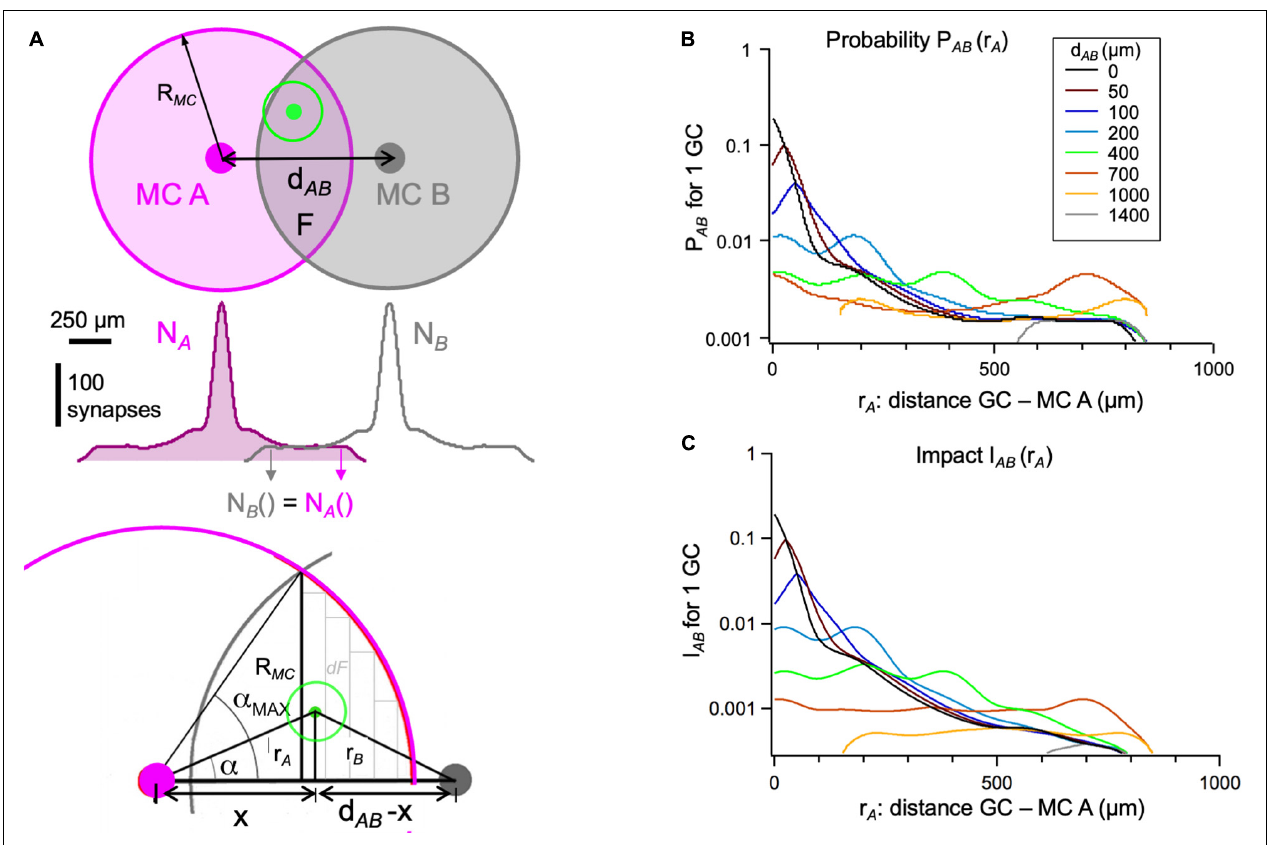
FIGURE 4 | Anatomical connectivity between pairs of mitral cells via one granule cell. (A) Top: Top view of the dendritic fields of MC A (magenta), a second MC B (gray) at distance d AB , and a GC (green) within the overlap area F of the MCs’ dendritic fields. Middle: Illustration of symmetry in N A (r) and N B (r). Bottom: Geometrical parameters relevant for the calculus in Eqs 9, 10 (see also Table 2 ). r A , r B : distance of GC from MC A resp. B. α : angle between the position of GC soma r A and d AB . α MAX : maximally possible α for the respective d AB . x: distance of projection of GC position onto d AB from MC A; relevant for integration. The gray rectangles represent the integration increments dF . (B) Probability P AB of a GC at position r A to connect to both A and B (Eq. 6), plotted for a set of distances d AB between mitral cells A and B (0–1400 µ m). The righthand peak in the curves for 200–700 µ m is due to the increased synaptic density around the soma of MC B. Parameters as given in Table 1 . (C) I AB : correction of P AB for a distance-dependent reduction in IPSP impact because of attenuation ( Figure 2C , Eq.